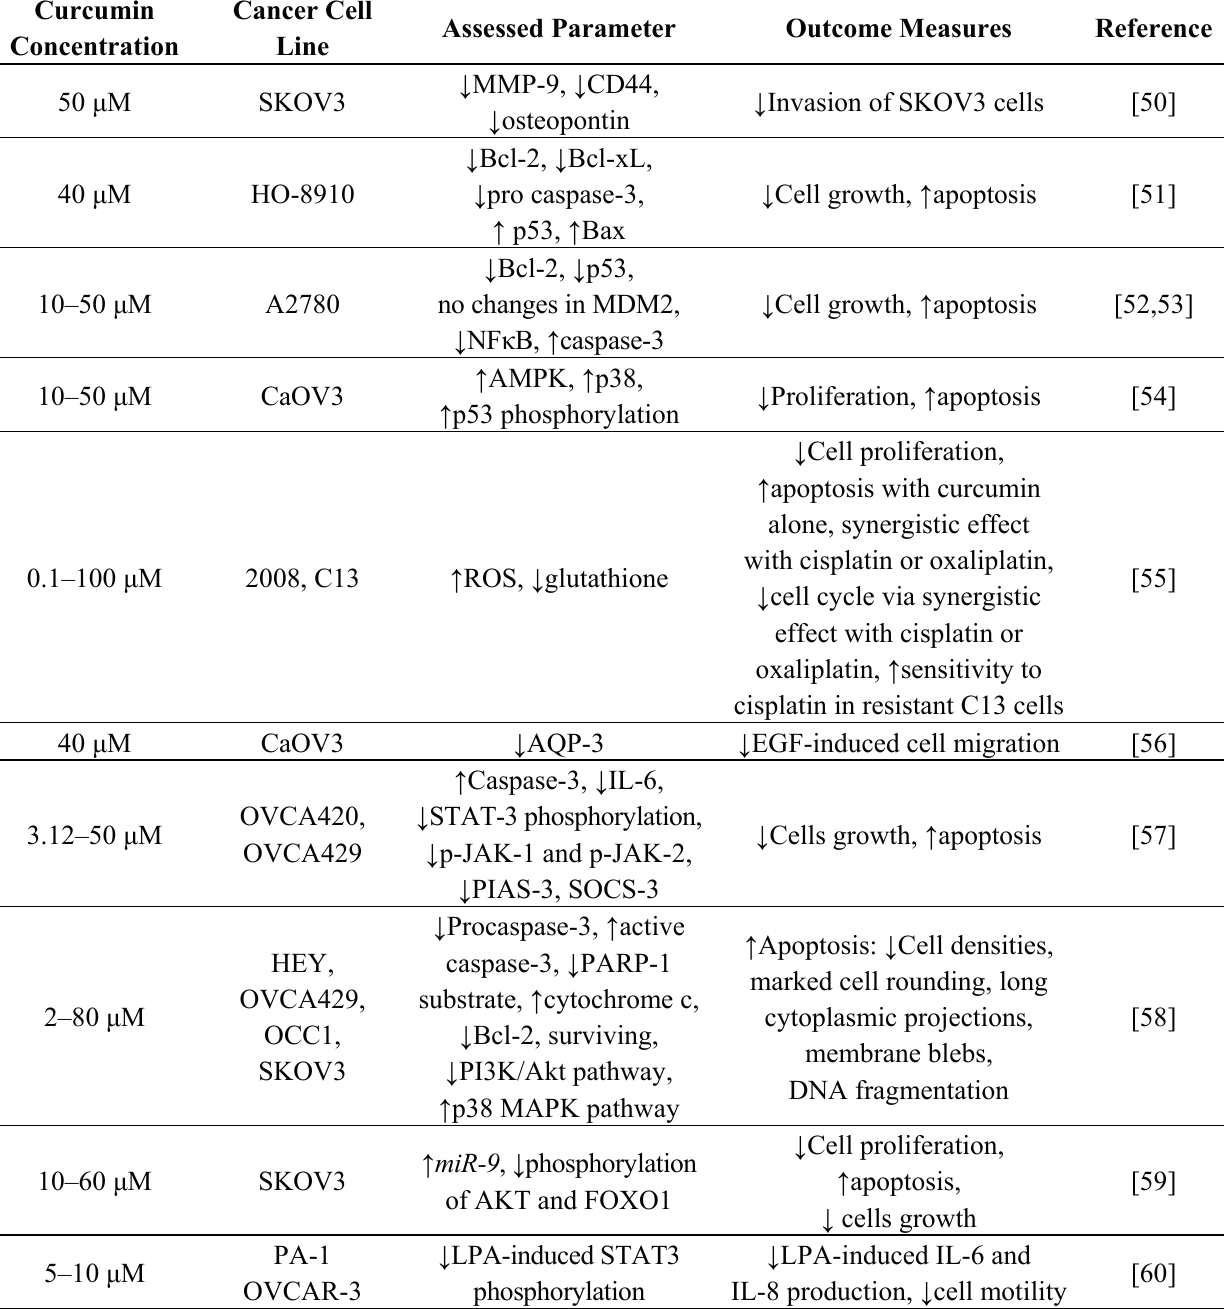
Table 1. Pleiotropic mechanisms of curcumin action in epithelial ovarian cancer cell/xenograft models. ↑ (high expression), ↓ (low